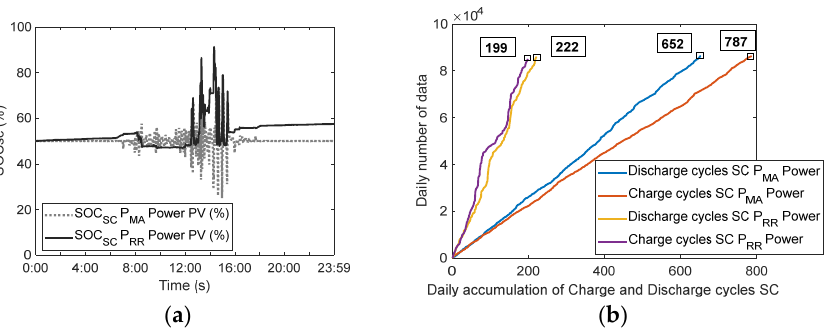
Figure 8. SC operability in Configuration 1, time step one second: ( a ) state of charge; ( b ) cumulative charging/discharging cycles.